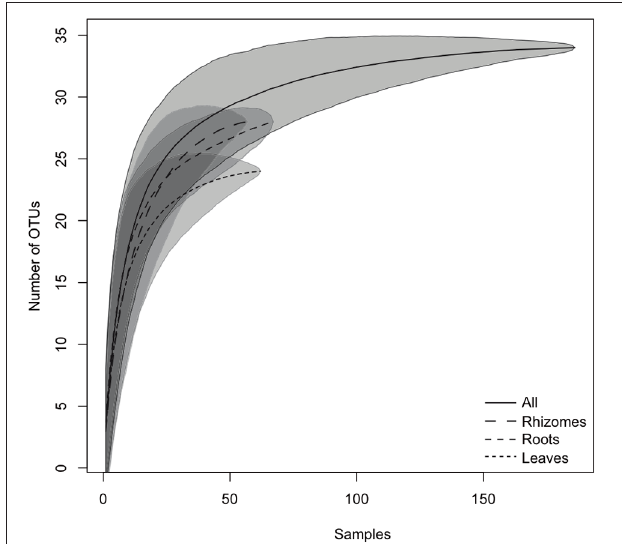
FIGURE 2 | Species accumulation curves of the endophytic bacterial community found in P. oceanica tissues. The lines indicate the averaged accumulated increase of detected OTUs vs. number of samples (10,000 bootstrap sampling replicates). The shadowed area indicates the standard deviation. The continuous line represents all the samples pooled together, and the dashed lines provide the values for the different